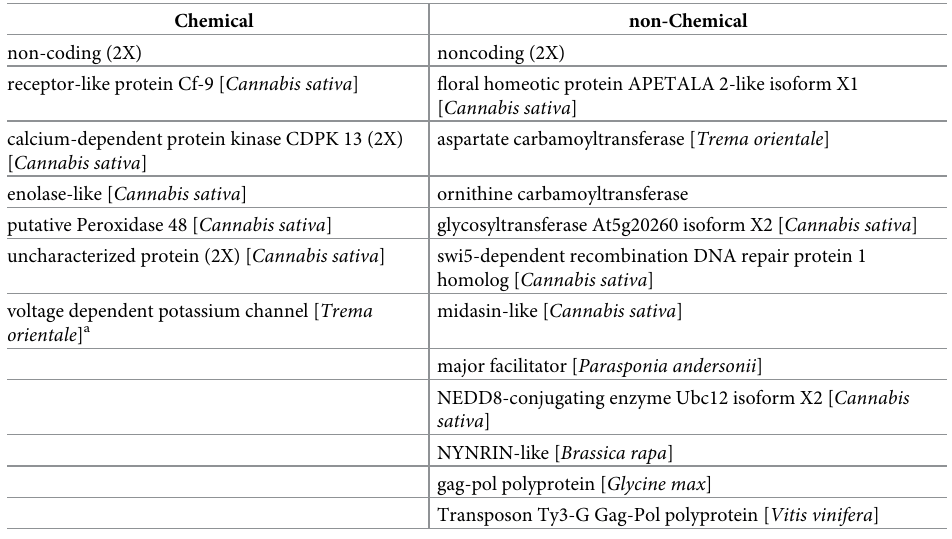
Table 4. Significant associations using Method